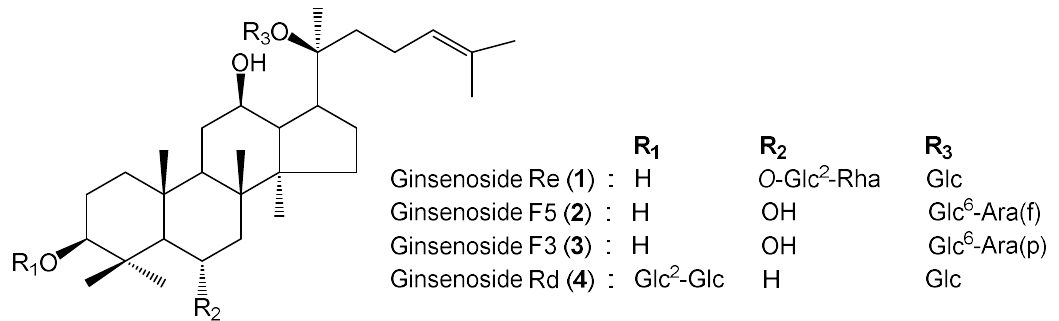
Figure 1. Structure of active compounds of ginseng berry. (Glc: β-D-glucopyranosyl, Ara(f): α-L-arabinofuranosyl, Ara(p): α-L-arabinopyranosyl, Rha: α-L-rhamnopyranosyl).